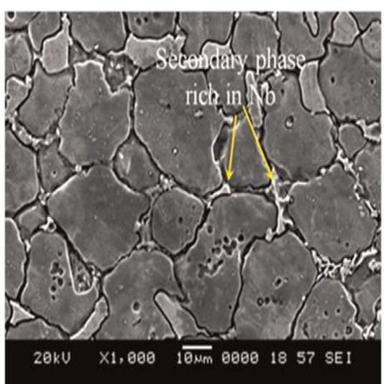
SEM micrograph of fusion zone showing the precipitation of secondary eutectic phase.